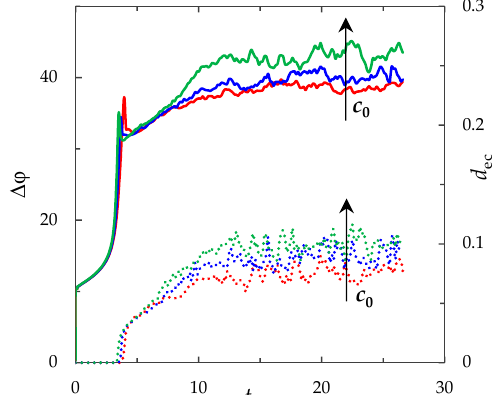
Figure 9. ChP (solid lines) and the average thickness of the electroconvective mixing layer, d ec (dotted lines). The results of computation for c 0 = 0.1 mol/m 3 (red lines), 0.3 mol/m 3 (blue lines), 1 mol/m 3 (green lines) at current density i av / i lim = 2.